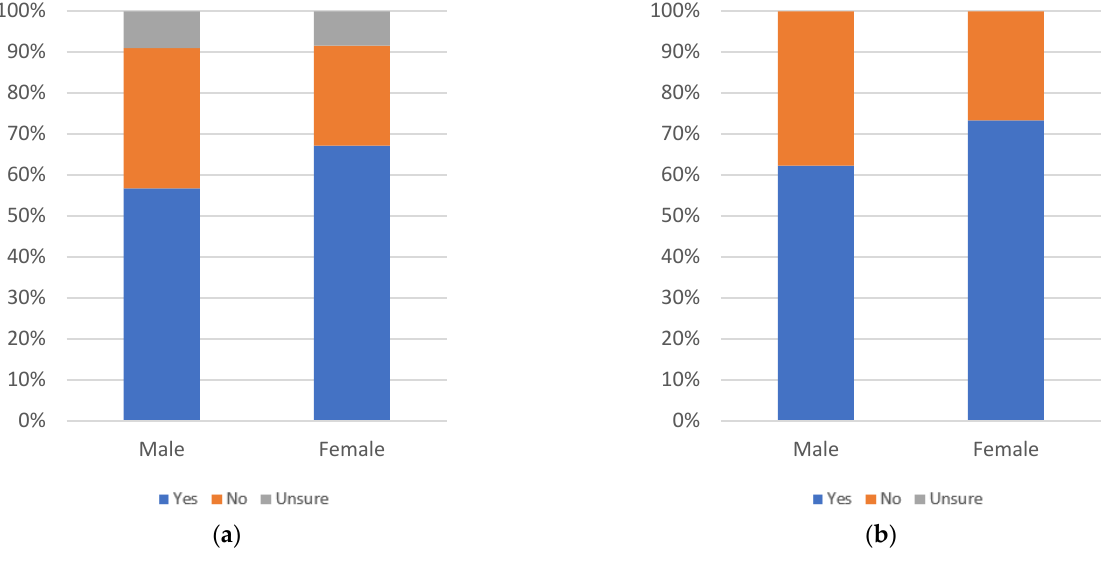
Figure 87. Label helpfulness, by gender: ( a ) with uncertain respondents (left) and ( b ) without uncertain respondents (right).